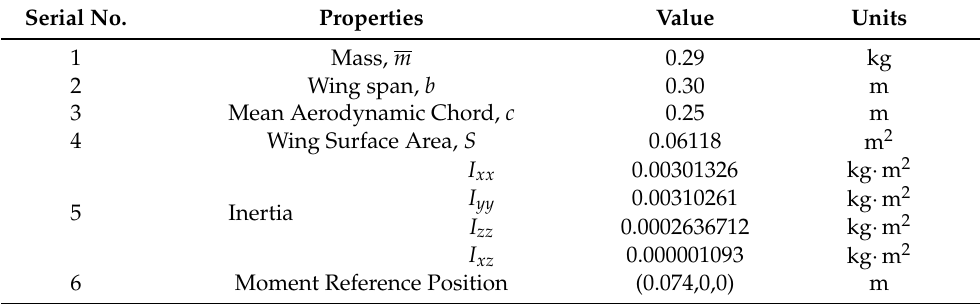
Table 1. Geometric properties of black